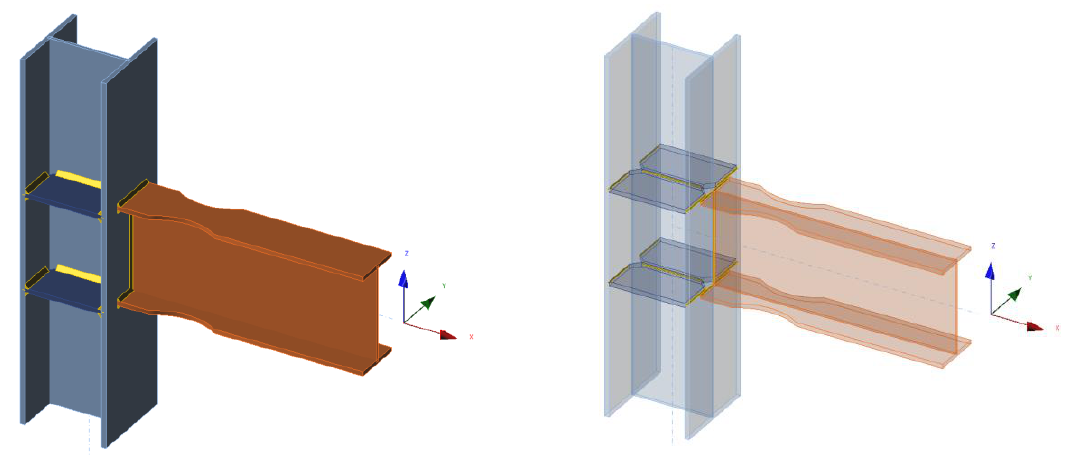
Fig. 4. Finite Element Model of the RBS